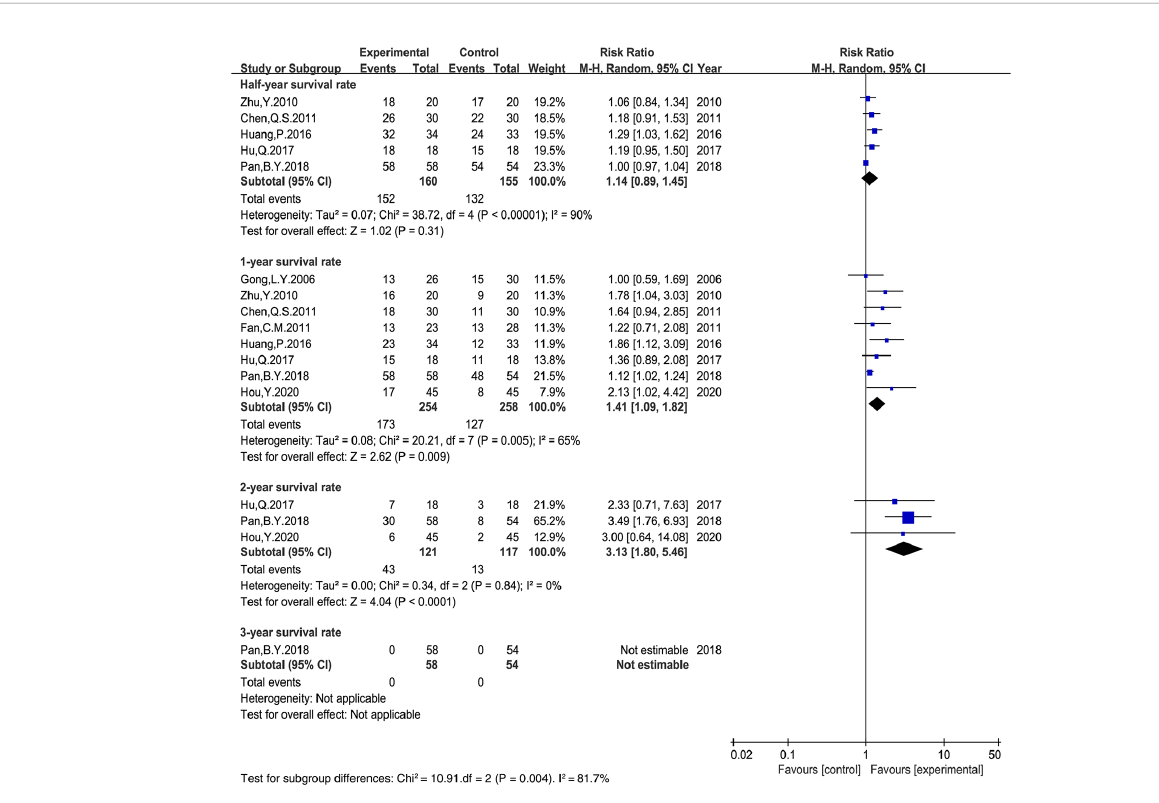
FIGURE 5 | Meta-analysis results of survival rate between the two groups.